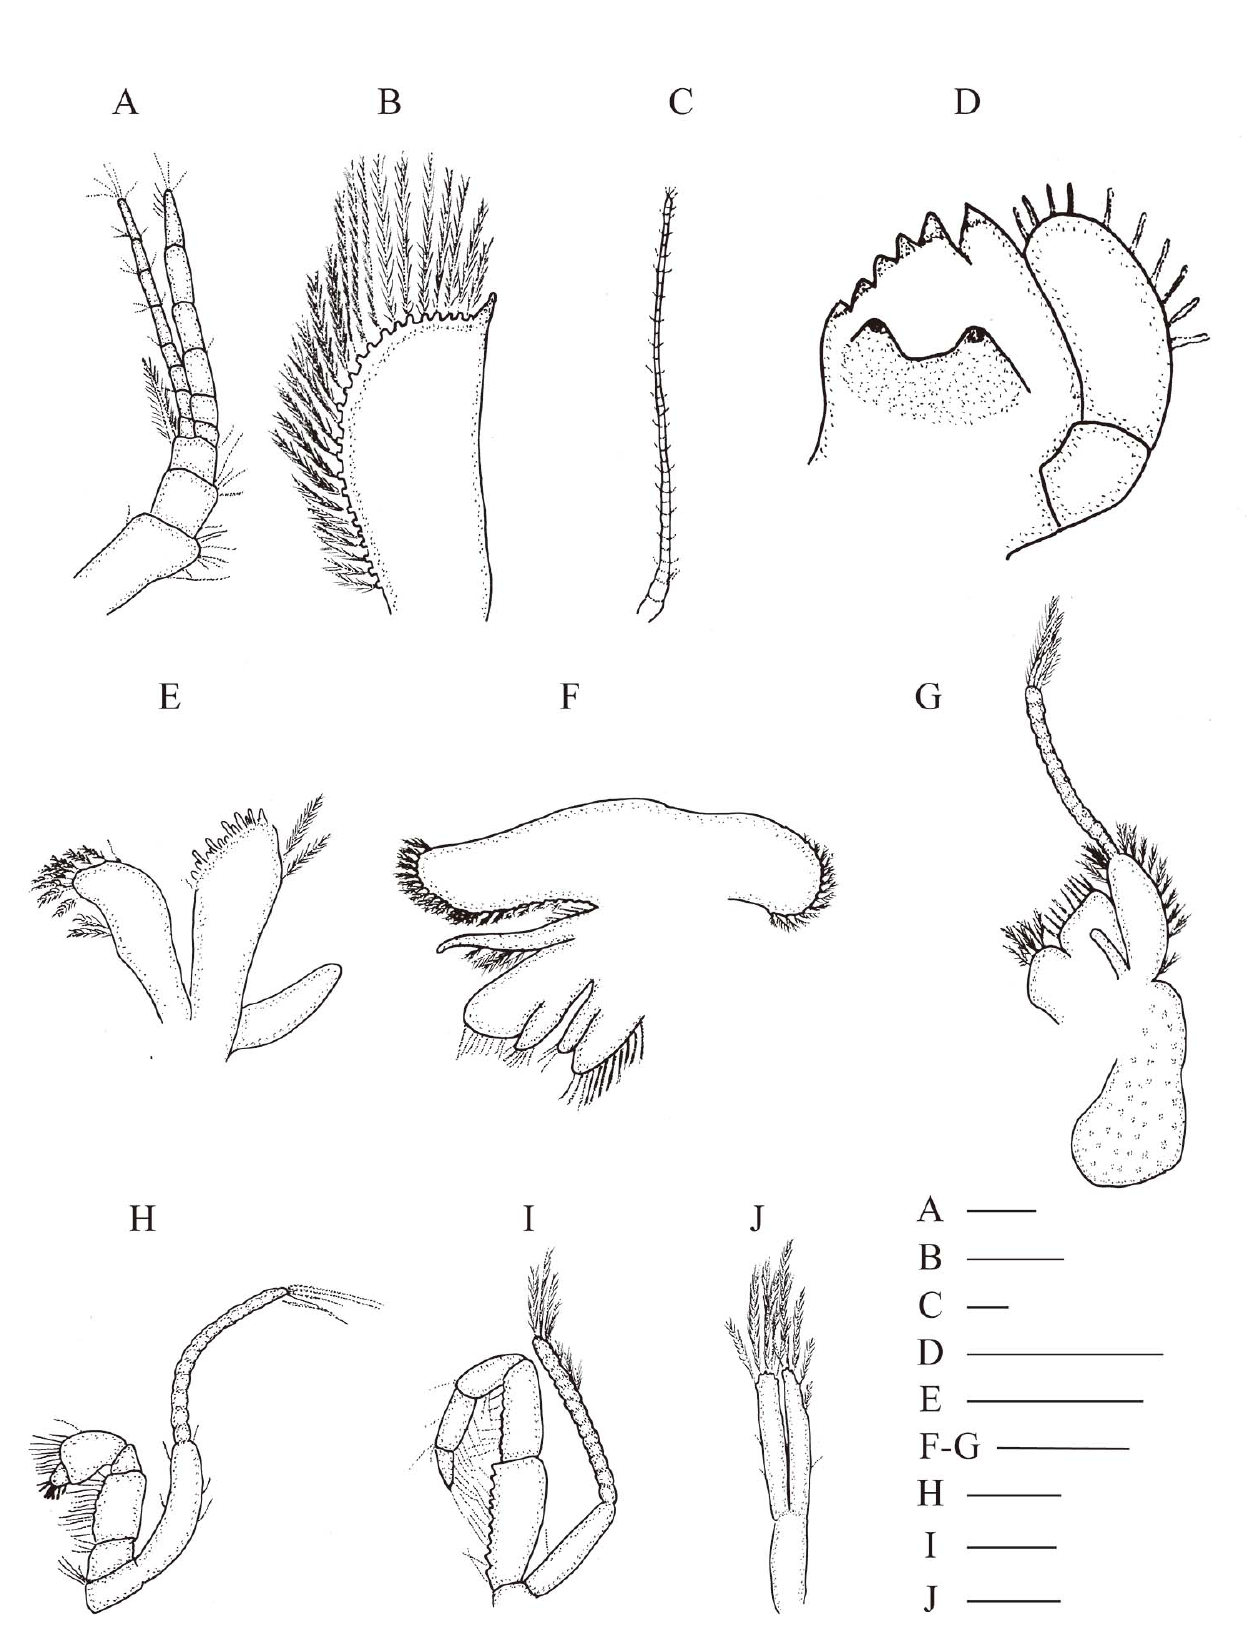
Figure 12. Juvenile Stage III of Procambarus virginalis . ( A ) Antenna 1, dorsal view; ( B ) antennal scale, dorsal view; ( C ) flagellum of antenna 2, dorsal view; ( D ) mandible, view of inside of mouth; ( E ) maxilla 1, oral view; ( F ) maxilla 2, oral view; ( G ) first maxilliped, oral view; ( H ) second maxilliped, oral view; ( I ) third maxilliped, oral view; ( J ) pleopod. Scale bars: 0.25